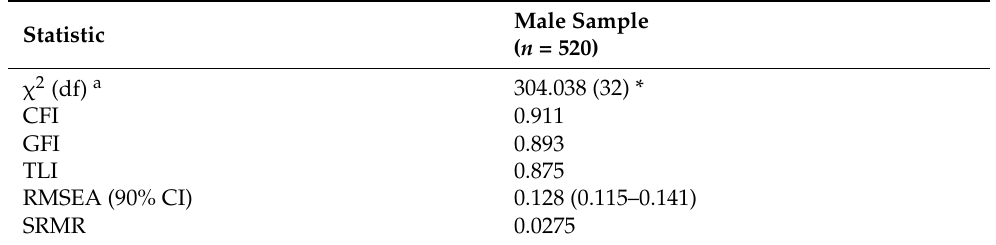
Table 5. Goodness-of-fit Indices for the Athletes’ Perceived Body Pressures from Coaches Question- naire for